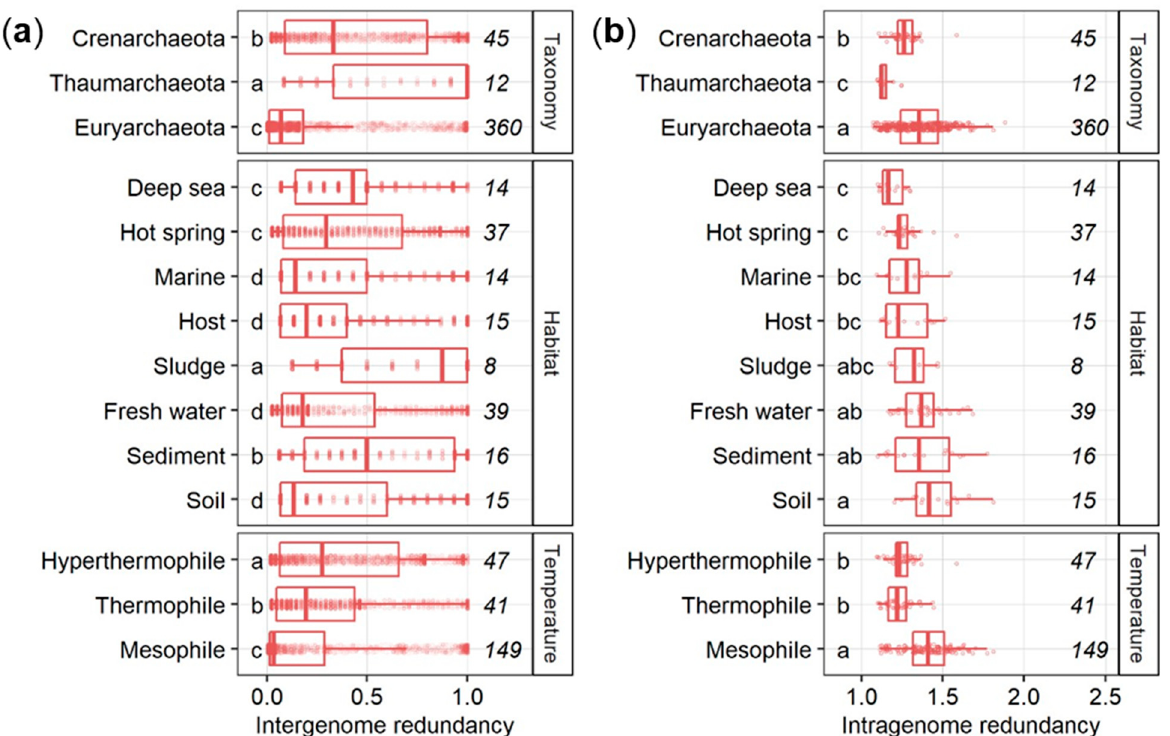
Figure 3. Intergenome ( a ) and intragenome functional redundancy ( b ) in archaeal phyla, habitats, and temperature ranges. The number of archaeal genomes is given in italic. Groups followed by a different letter are significantly different according to the HSD-test ( p < 0.05).